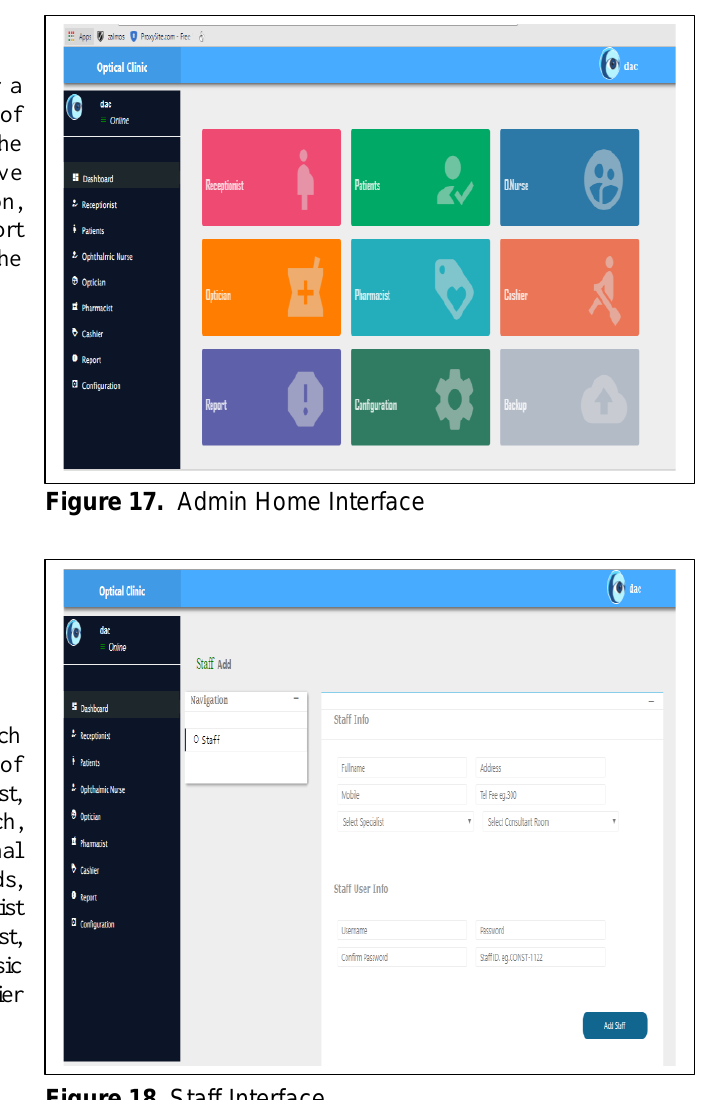
Figure 16. Login Interface